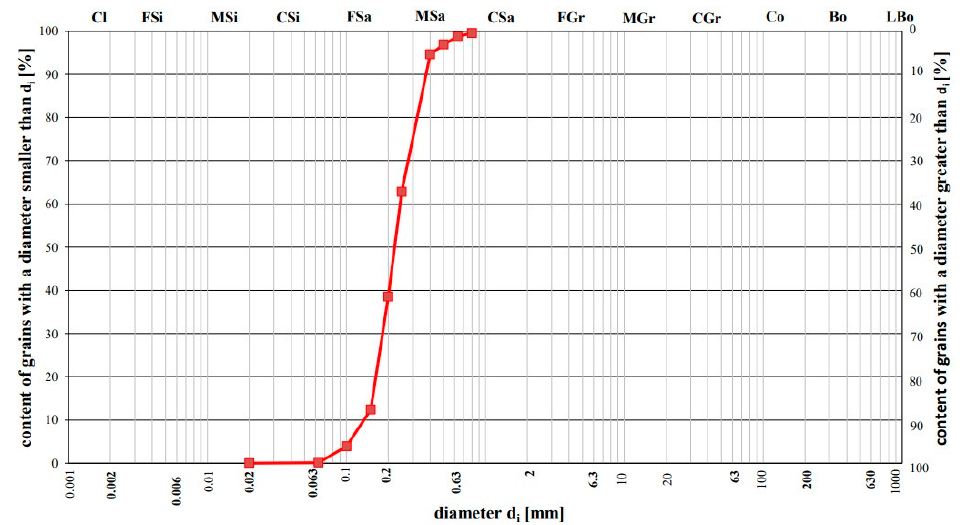
Figure 2. Grain size distribution of input quartz sand used in the Gda ń sk 2021 experiment. Table 1. Main parameters and transport results of the Gda ń sk 2021 experiment.